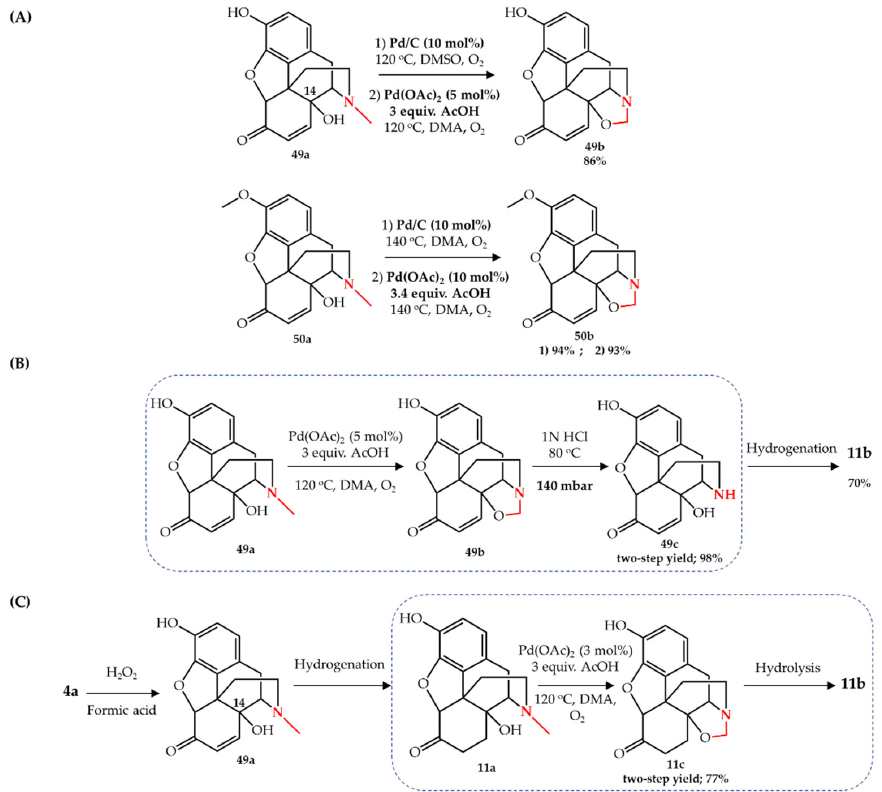
Figure 8. Pd ‐ catalyzed oxazolidination of opiates: ( A ) 14 ‐ hydroxymorphinone 49a and 14 ‐ hydroxycodeinone 50a according to Gutmann et al. [69], ( B ) 49a according to Gutmann et al. [69] , and ( C ) oxymorphone 11a according to Gutmann et al. [13].